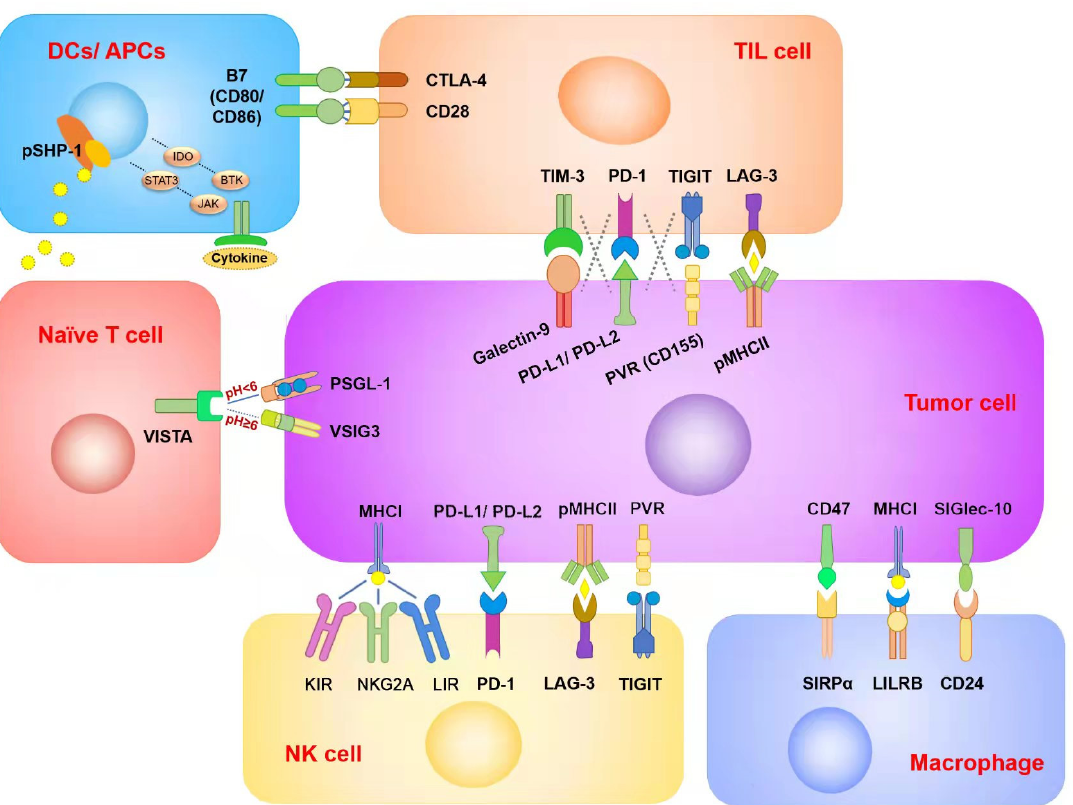
Figure 1. Summary of immune checkpoints in different immune cells and tumor cells. Each ICI was targeted to different cell types. Although two of the ICIs’ target receptors and corresponding ligands are in the same checkpoint signaling pathway, there are also differences in therapeutic efficacy and side effects between them. In addition, there may be overlapping inhibitory effects between different checkpoint signaling pathways in the same immune cell type. This is one of the reasons for ICI resistance. Table 1. Clinical trials of different kinds of ICIs for immunotherapy.